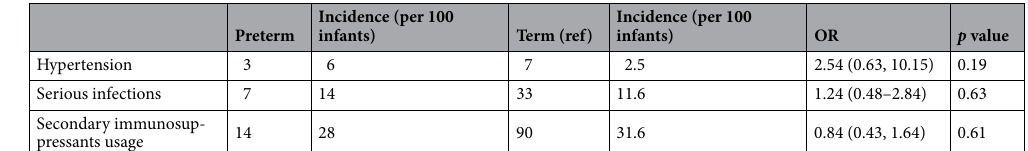
Table 3. Odds ratio for nephrotic syndrome complications and use of immunosuppressants other than steroids. ESRD End stage of renal disease.